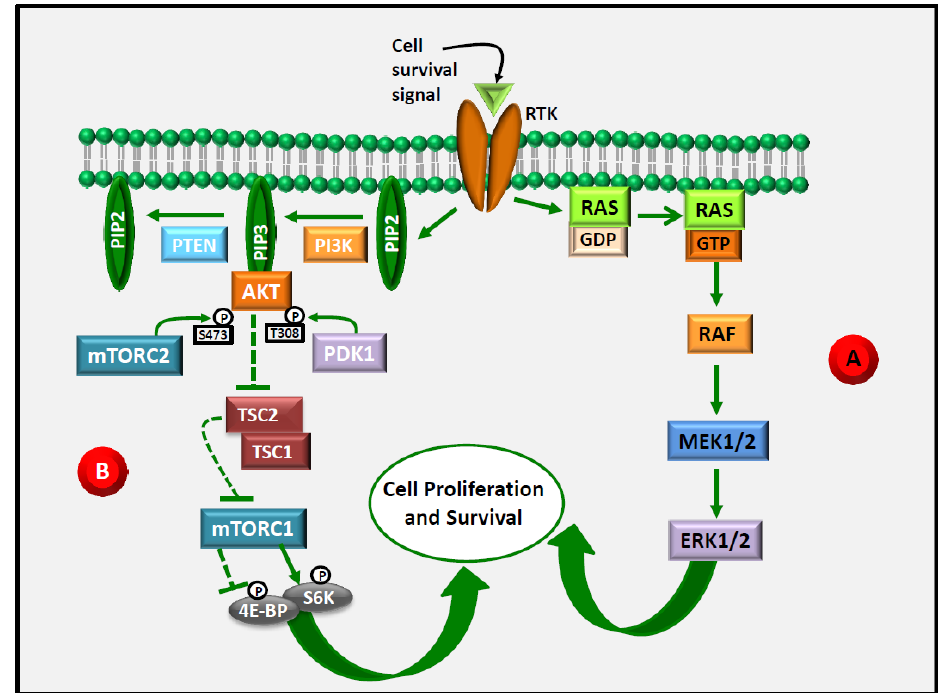
Figure 1. Activation of the RAS/ERK and phosphoinositide cell signaling pathways following the binding of cell survival signals to receptor tyrosine kinases (RTK). The two pathways are triggered by the activation of RTK in the cell membrane. After the binding of RTK by cell survival signals, the RTK intracellular domain is phosphorylated and ( A ) through several steps it allows the binding and activation of RAS. Consequently, RAF, the first MAPK in this pathway, is recruited and activated and, in turn, it phosphorylates and activates MEK1/2, which finally activates ERK1/2 by the dual phosphorylation on tyrosine and threonine. In turn, ERK activates a variety of substrates placed downwards that ultimately induce cell proliferation and survival; ( B ) PI3K is associated with the intracellular domain of RTK and activated to catalyze the PIP2 phosphorylation into PIP3 that recruits AKT. In this form, AKT can be activated by the dual phosphorylation carried out respectively by PDK1 and mTORC2. Activated AKT regulates the activities of downstream targets that ultimately lead to the induction of cell proliferation and survival. PTEN may regulate this pathway by dephosphorylating PIP3. See the text for more details regarding the components and reactions of the two signaling pathways.